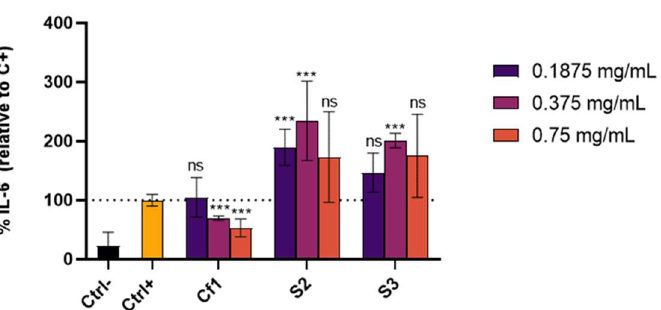
Figure 3. IL-6 secreted by HaCaT cells treated for 24 h with different extracts concentrations and 15 µ g/mL LPS. Ctrl—-cells incubated with only culture media; Ctrl+—Cells incubated with culture media + inflammation inductor (LPS); Cf1– cells incubated with Cf1 extract from codfish frames + inflammation inductor (LPS); S2, S3—cells incubated S2 and S3 extracts from sardine wastes + inflammation inductor (LPS). The results are expressed as mean IL-6 percentage relatively to the positive control ± SD. The symbol * indicates significance relative to the positive control (*** p -value ≤ 0.001); ns—not